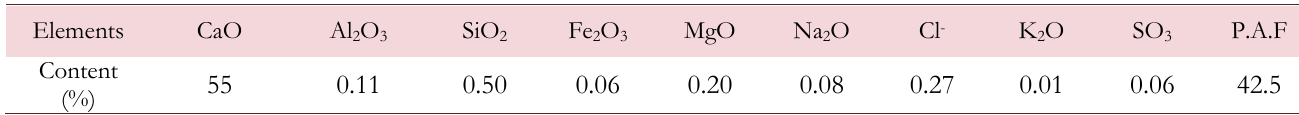
Table 4: Chemical composition of limestone filler according to the